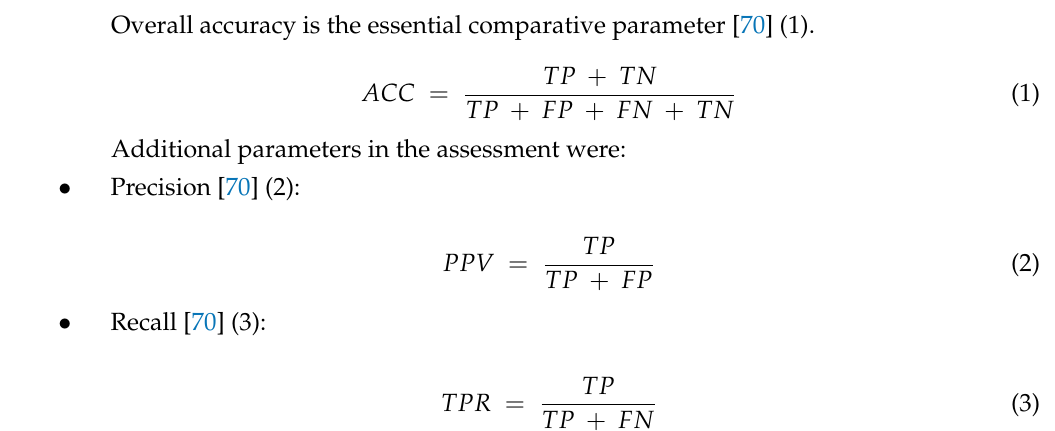
Table 2. Confusion matrix for a binary classification. Actual Positive Actual Negative Predicted positive True positives TP False positives FP Predicted negative False negatives FN True negatives